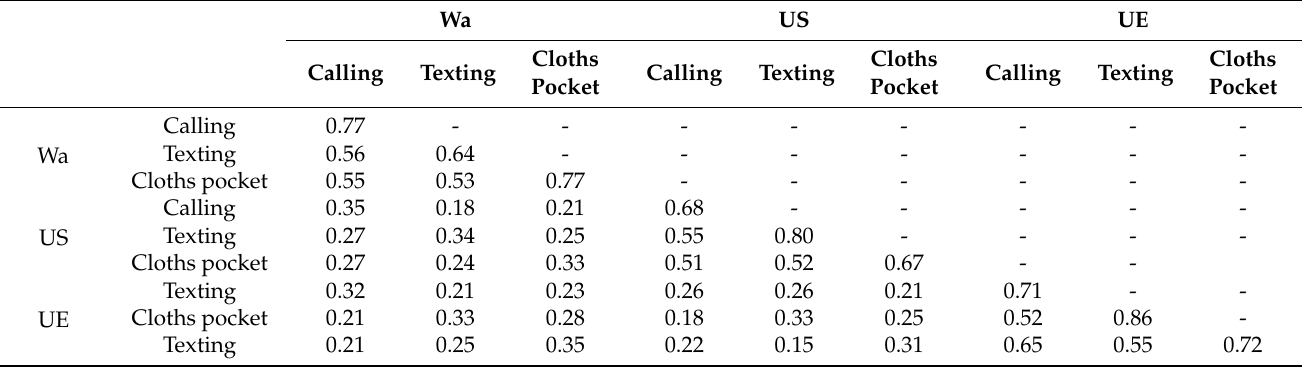
Table 1. Pearson correlation coefficients of different motion modes and different smartphone